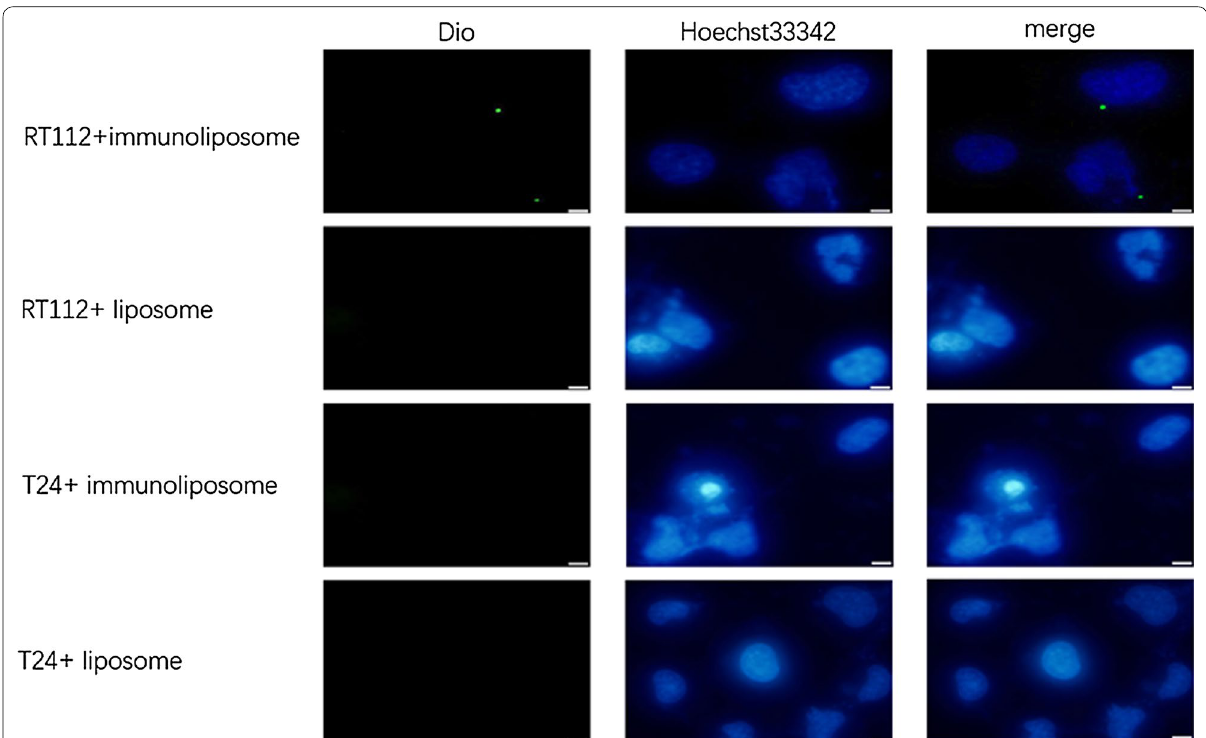
Fig. 7 Dio delivered by ScFv-PEG2000-DSPE into RT112 cells in vitro. The immunoliposomes or liposomes containing 0.1% Dio were incubated with RT112 cells and T24 cells in cell incubator for 3 h in the dark. Hoechst 33342 was used to label cell nuclear. The left panel displayed the green Dio in different treatment groups, the middle panel showed the blue cell nuclear stained by hoechst 33342, and the right panel showed merged figures of two colors. The cells were observed under a fluorescent microcopy. Bar 50 =